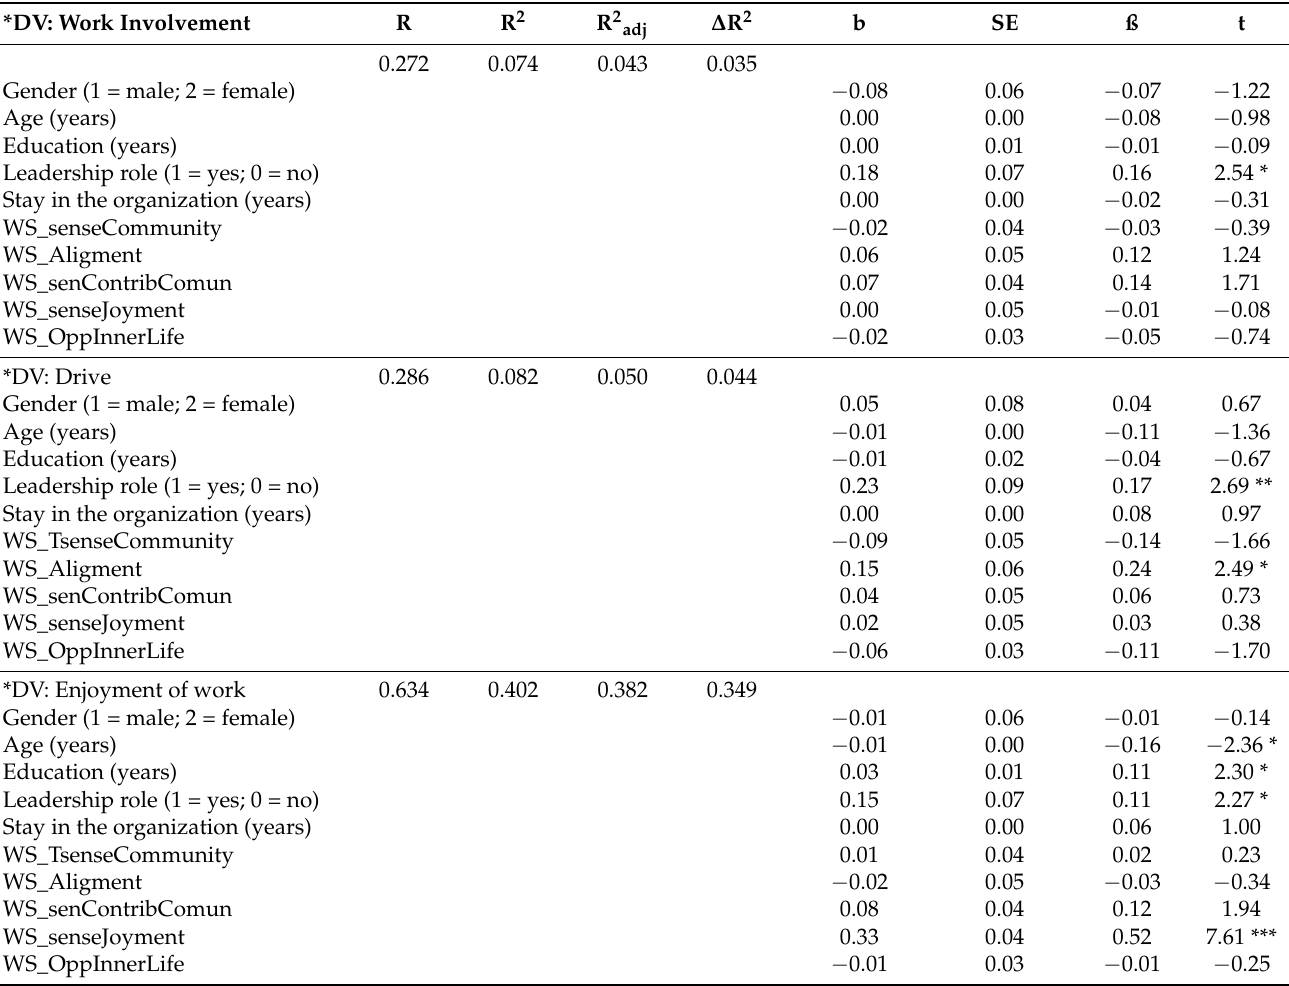
Table 3. Hierarchical Multiple Regression of dimensions of workaholism predicted by workplace